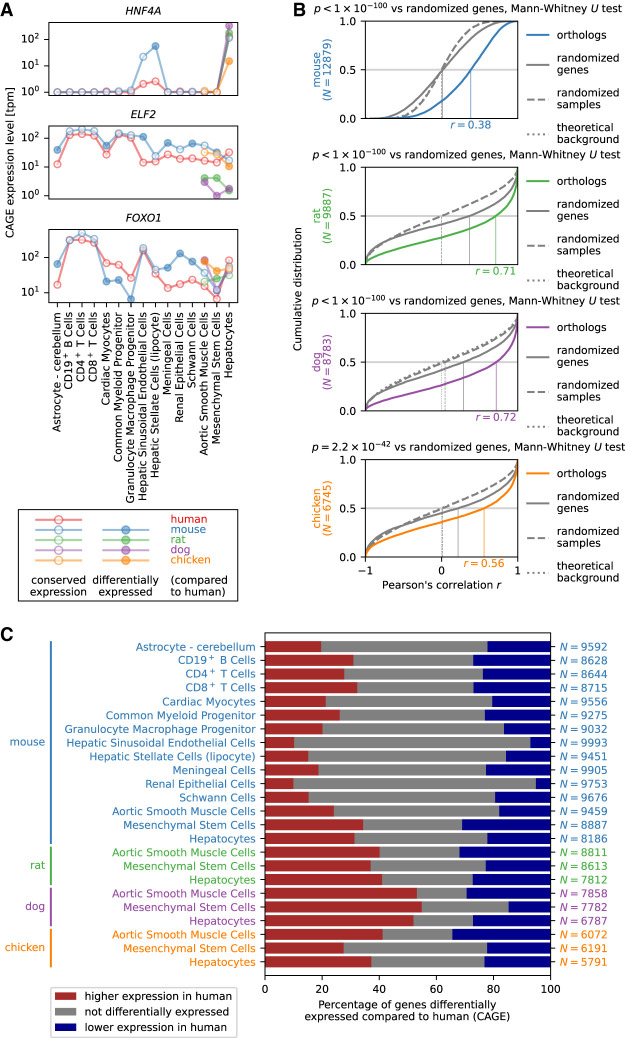
Differential gene expression analysis. (A) Expression profile of HNF4A, ELF2, and FOXO1 as examples of genes with an expression profile highly correlated across cell types between species but with significant expression level differences between species in specific cell types. (B) Cumulative distribution of Pearson's correlation r across cell types in gene expression between human and mouse, rat, dog, or chicken. The number N of expressed orthologous genes included in the distribution is shown in the vertical axis label, and the estimated median value of r is indicated on the horizontal axis of each graph. The background distribution of r obtained by randomizing genes (solid curve) or randomizing samples (dashed curve) as well as the theoretical background distribution of r for an uncorrelated bivariate normal distribution (dotted curve) are shown in gray; the latter two largely coincide. The statistical significance was calculated using the Mann–Whitney U test comparing Pearson's correlation values for orthologs to the background distribution of r for randomly paired genes between human and mouse, rat, dog, or chicken. Note that the median correlation values are not directly comparable between species, as the sets of orthologous genes are different. (C) Differential gene expression analysis of orthologous genes in human compared to mouse, rat, dog, and chicken. The red and blue bars correspond to the percentage of expressed orthologous genes with significantly (Benjamini–Hochberg corrected P < 0.1) higher and lower expression, respectively, in human compared to mouse, rat, dog, or chicken. The number N of orthologous genes expressed in each cell type is shown on the right.